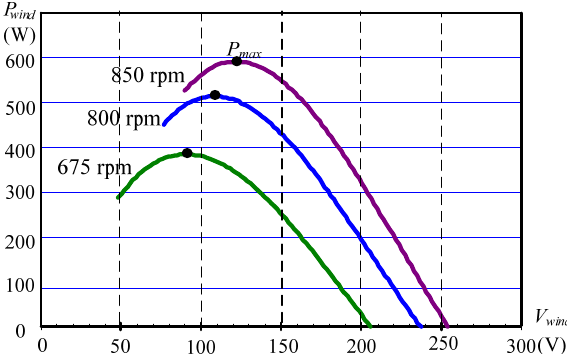
Figure 11. Typical output power characteristic curves of the wind turbine under different wind speeds.